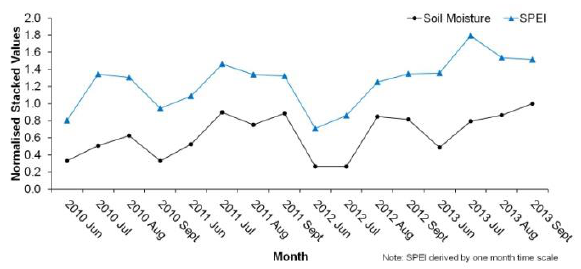
Figure 8. Monthly temporal variation of soil moisture against SPEI.